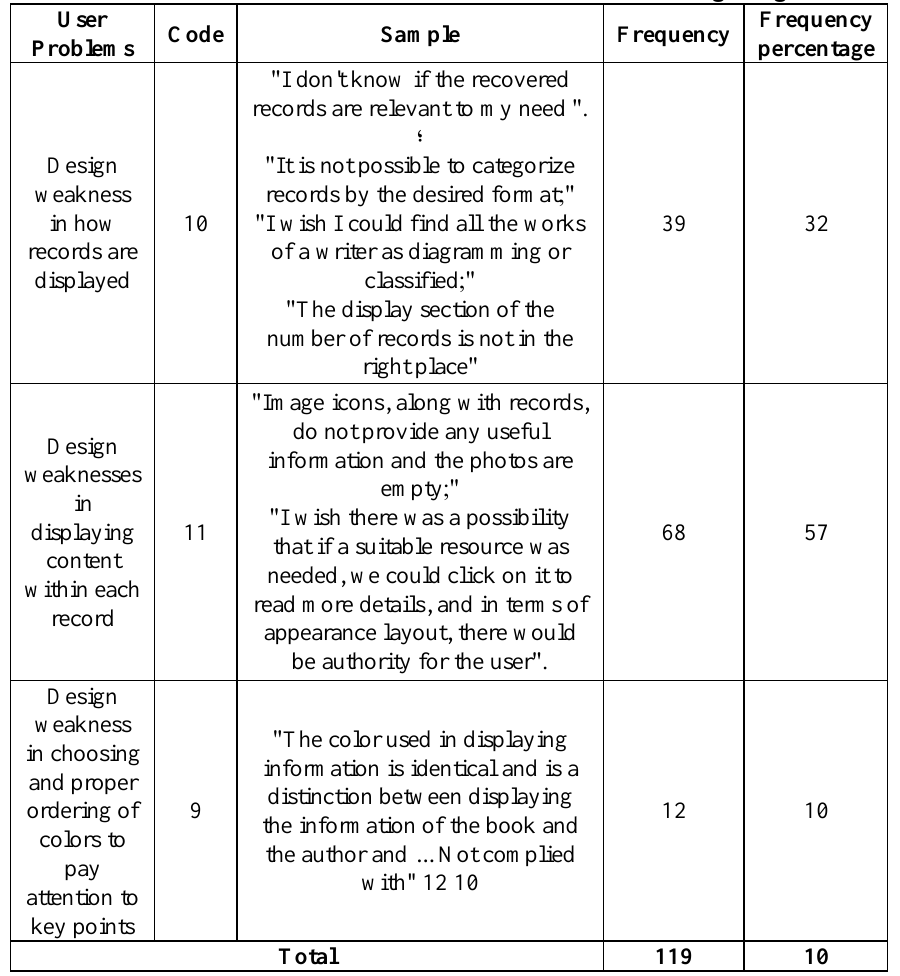
Table 8 - Codes of Visual Elements of the Findings